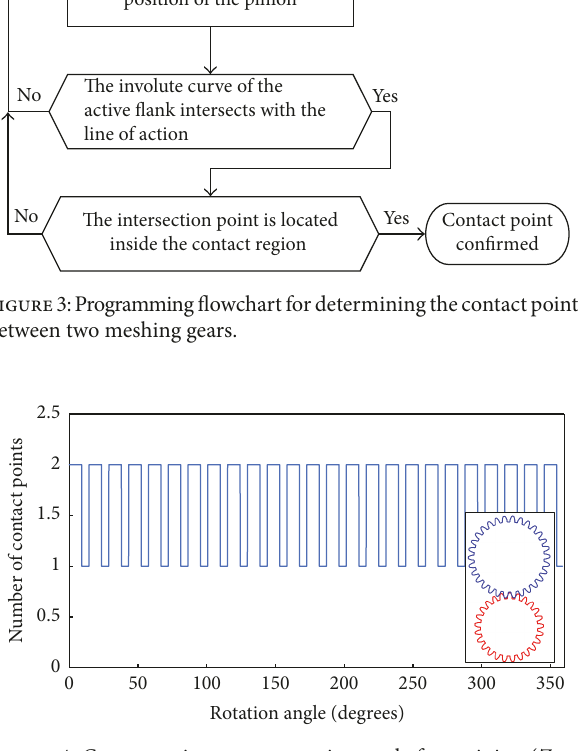
Figure 4: Contact points versus rotation angle for a pinion ( 𝑍𝑝 = 25 ) and a gear ( 𝑍𝑔 = 30 ).